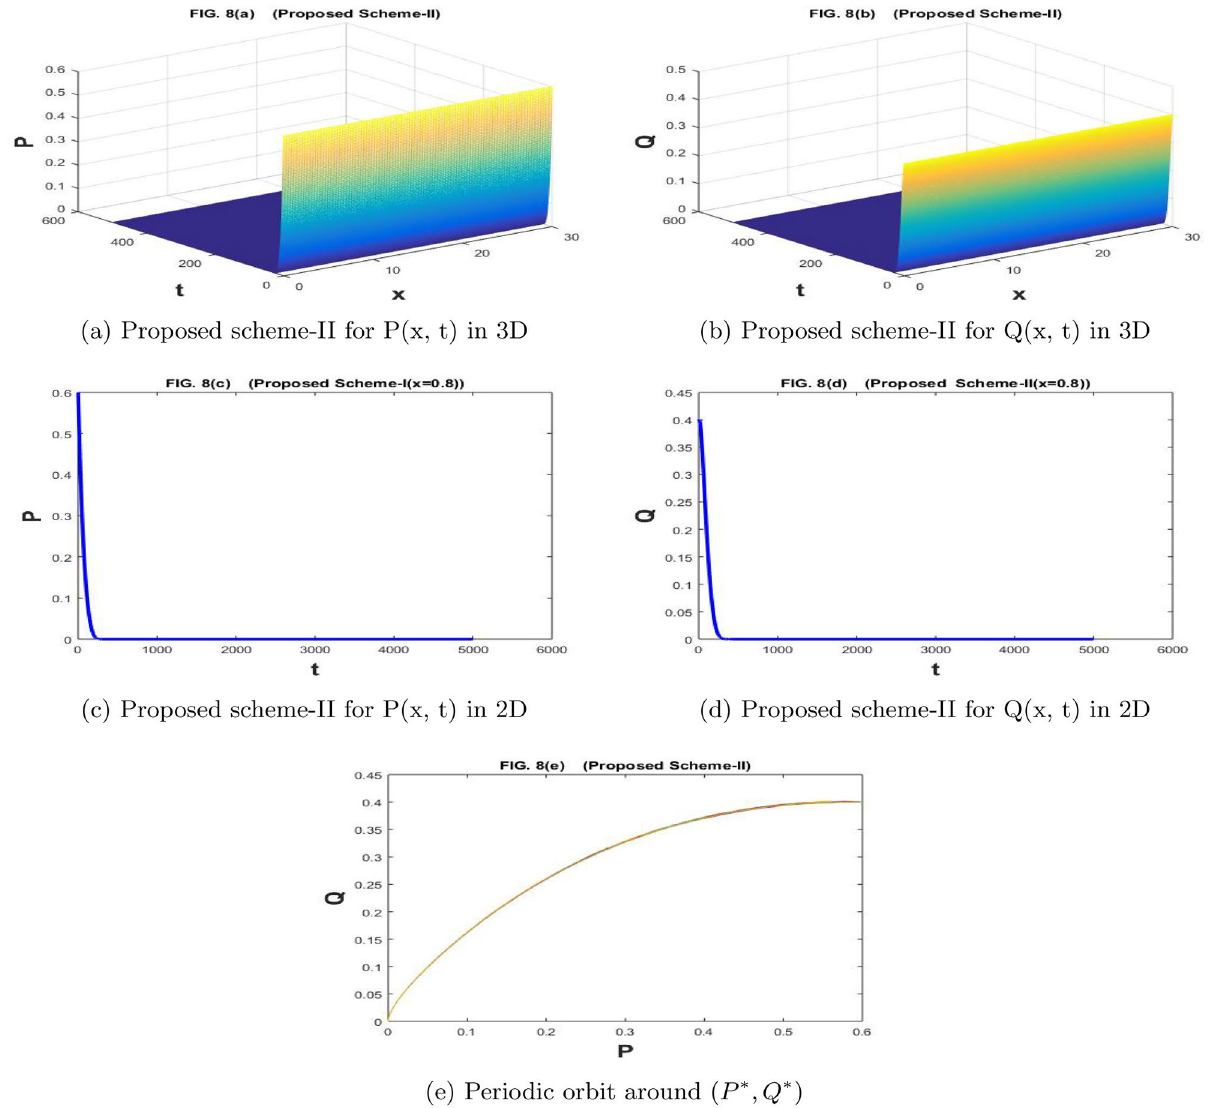
Figure 8. The subfig ( a and c ) and ( b and d ) represents the numerical approximation of P ( x , t ), and Q ( x , t ) respectively by proposed scheme-II. The subfig ( e ) represents the periodic orbit around ( P ∗ , Q ∗ )